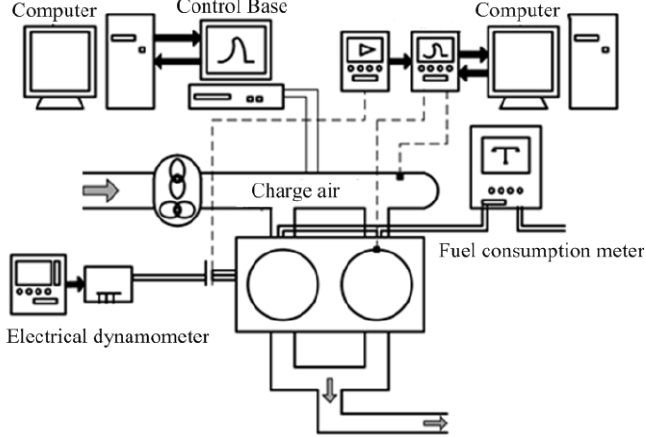
Figure 3. Opposed-piston folded-cranktrain (OPFC) diesel engine experimental